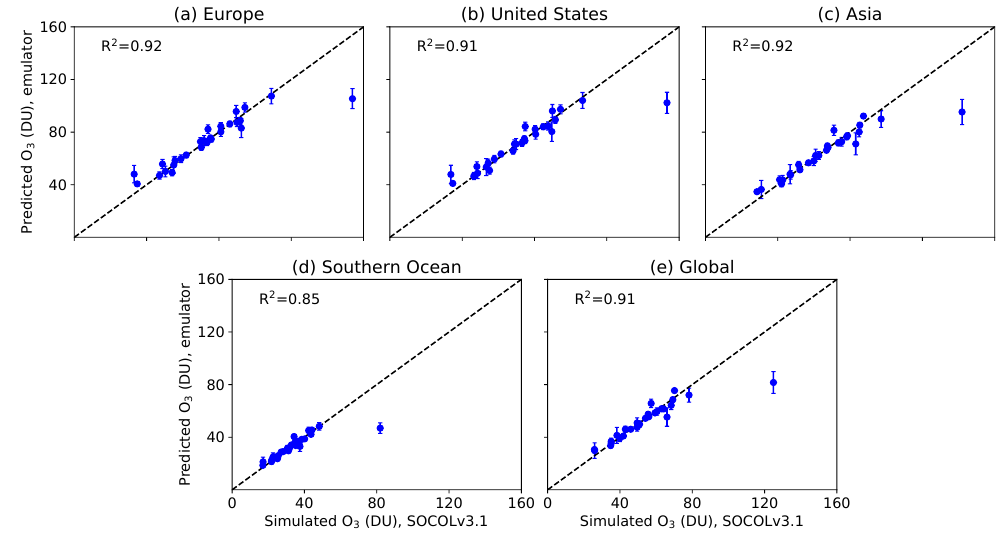
Figure 3. Tropospheric column ozone as predicted by the GP emulator vs. the amount simulated in SOCOLv3.1 test simulations (i.e. the simulations used to validate the emulator). The error bars indicate the uncertainty (mean ± standard deviation) on the GP emulator output, and the 1 : 1 line and coefficient of determination ( R 2 value) are also shown. These simulations correspond to running the GP emulator and the simulator (SOCOLv3.1) at each of the 27 validation inputs, for (a) Europe (37–60 ◦ N, 0–42 ◦ E); (b) United States (32–52 ◦ N, 67–124 ◦